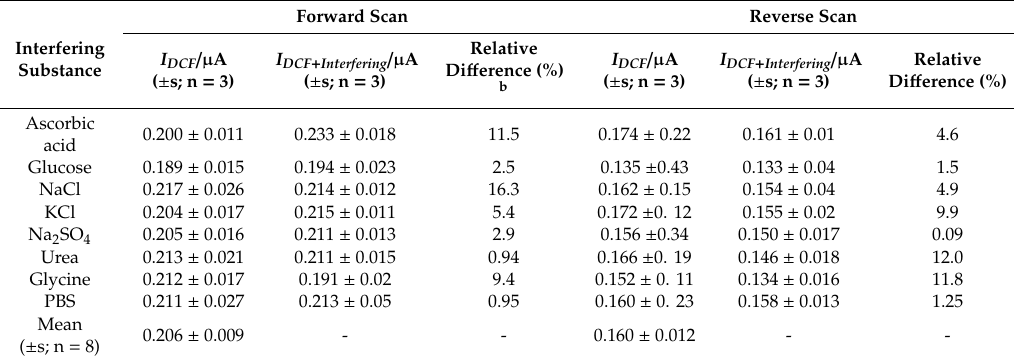
Table 2. E ff ect of the potential interfering substances on the determination of diclofenac (DCF microscale ITIES array a